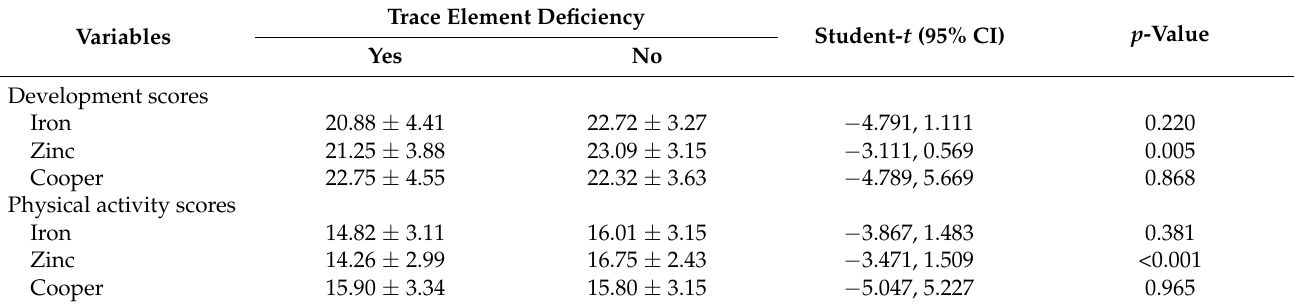
Table 6. Association of trace element deficiency with development and physical activity